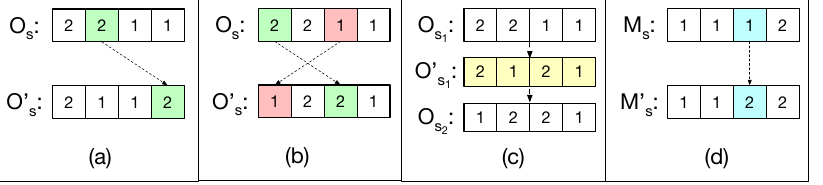
Figure 2. Operators used in the global neighborhood. ( a ) Insertion. ( b ) Swapping. ( c ) Path-relinking. ( d ) Mutation of M s .